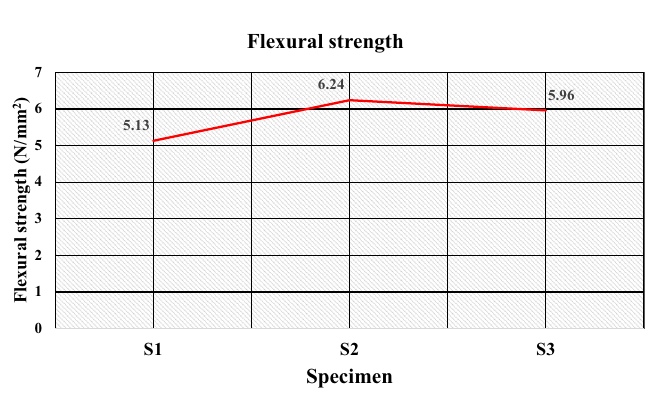
Figure 15. Flexural strength of the specimens.